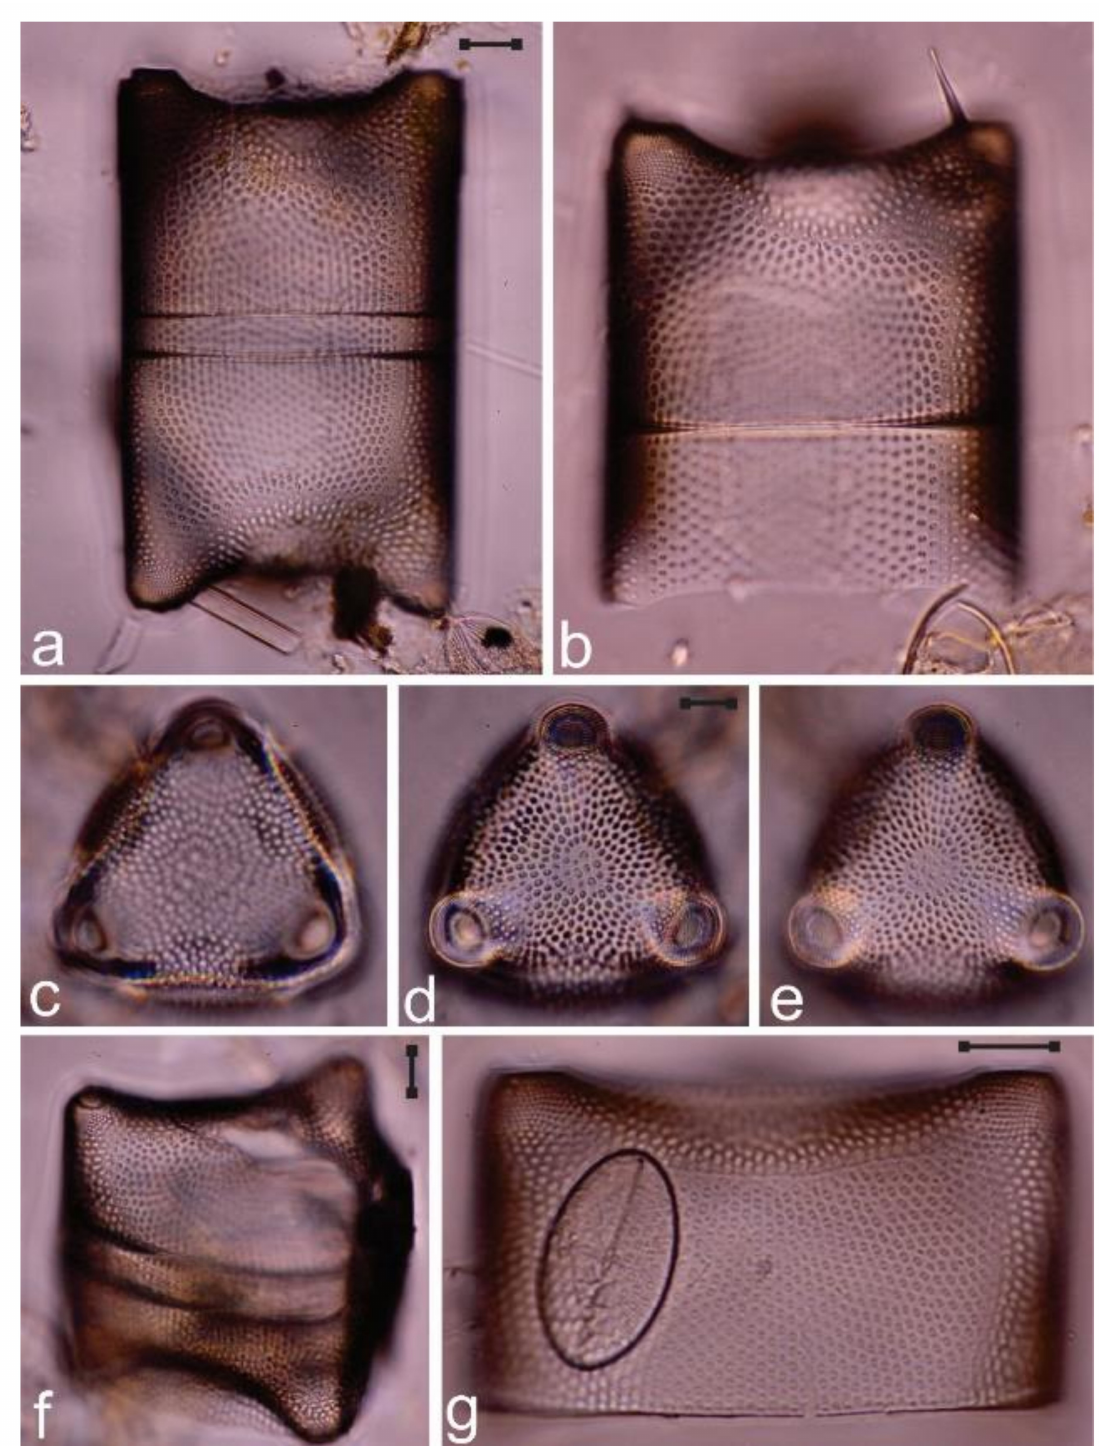
Figure 14. ( a – g ) Lampriscus shadboltianum , images a , b , f , g frustule in girdle view showing the cingulum, image b valve exterior, short elevations with ocelli at apices and submarginal spine. Scale bar = 10 µ